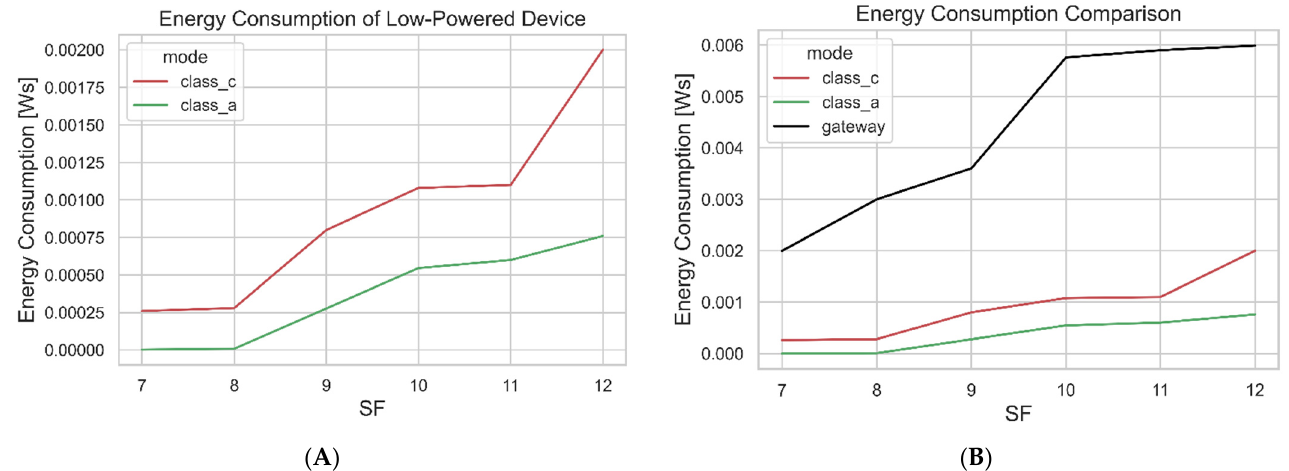
Figure 25. ( A ) Low-Powered Device Energy Consumption and ( B ) Gateway Energy Consumption.